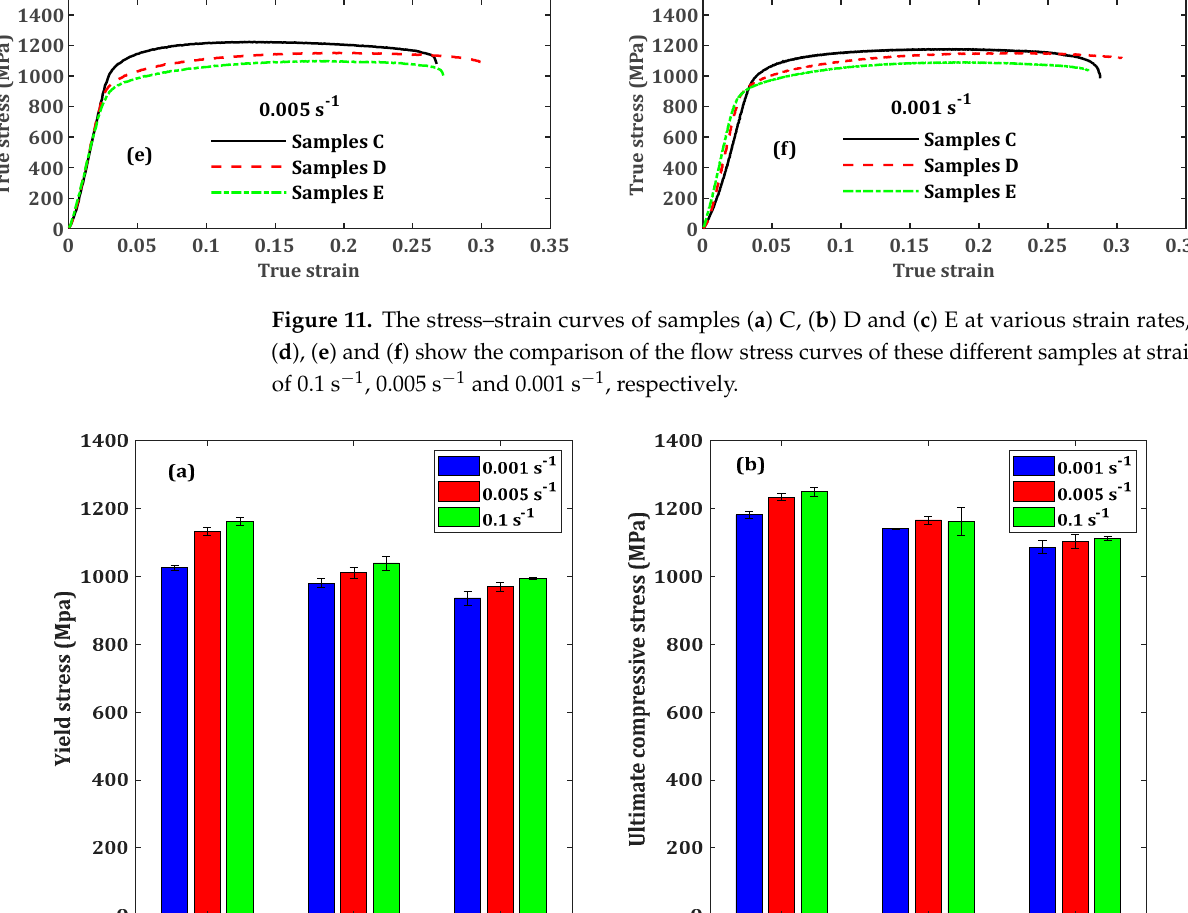
Figure 12. Comparison of ( a ) the yield and ( b ) ultimate compressive stress of various forms of LPBF Ti6Al4V(ELI) at different levels of strain rate.